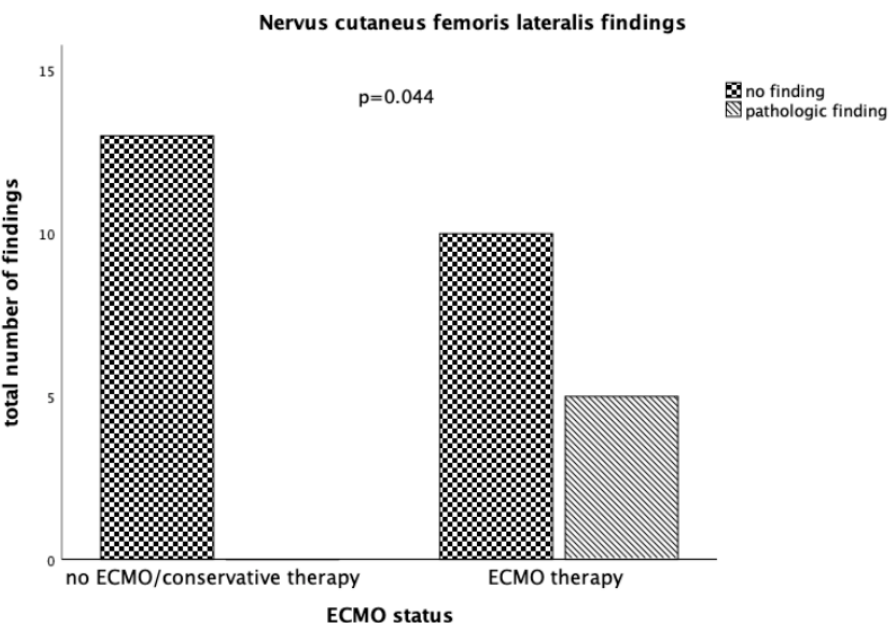
Figure 2. Displayed are the examination results regarding findings in the nervus cutaneus femoris lateralis separated by ECMO status. In the conservative therapy group there were no pathologic findings regarding this nerve, whereas in the group of patients managed with ECMO a third of patients had pathologic findings in the supply area of this nerve. The differences between those two groups are statistically significant.